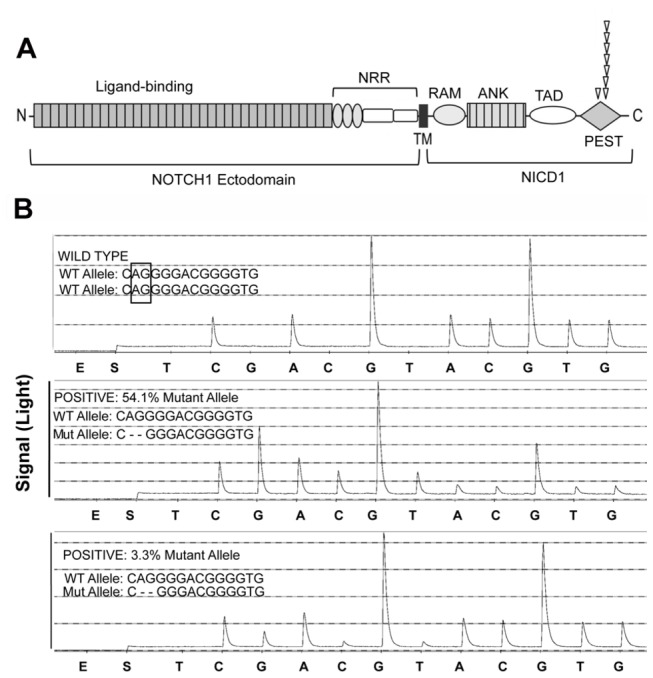

NOTCH1 mutations in CLL.A) Position of NOTCH1 mutations, superimposed on a cartoon showing the NOTCH1 protein. NRR, negative regulatory region; RAM, RAM domain; ANK, ankyrin repeat domain; TAD, transcriptional activation domain; PEST, degron domain. B) Representative confirmatory pyrosequencing results in CLL cases positive by deep sequencing for the NOTCH1 codon 2514 del(CT) mutation. Results for a case with wild type codon 2514 sequences is shown in the upper panel. The lower two panels are cases in which deep sequencing revealed high (54.1%) or low numbers of mutated reads (3.3%). Reverse-sequences of the wild type (WT) and mutant (MUT) del(CT) alleles are shown for reference. “E” corresponds to the addition of enzyme to the reaction chamber, while “S” corresponds to the addition of the substrate. In this sequencing by synthesis assay, nucleotides are added to the reaction chamber sequentially in the order shown. Nucleotide incorporation releases pyrophosphate, which catalyses a reaction in which the number of photons produced is proportional to the number of nucleotides incorporated. The codon 2514 del(CT) mutation causes the appearance of a new signal corresponding to the incorporation of 3 G residues.